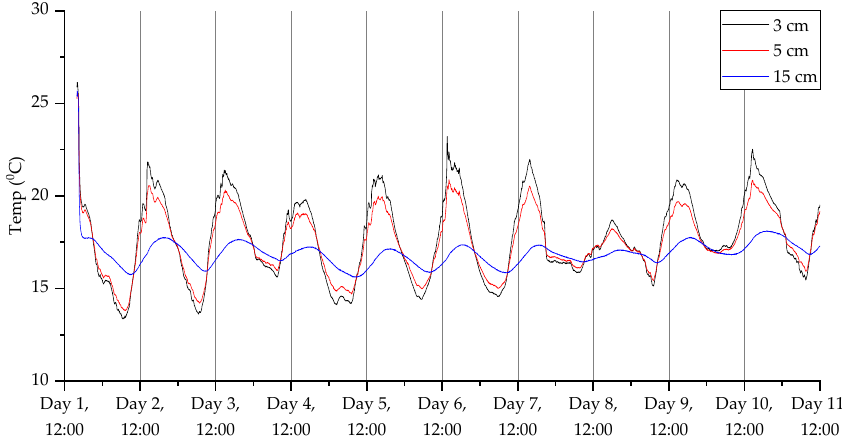
Figure 19. Temperature measurements for the third deployment in Wellesbourne campus woodland. Figure 19: Temperature measurements for the third deployment in Wellesbourne cam ‐ Data collection commenced on 26 August 2022 at 16:00 (24 h pus woodland. Data collection commenced on 26 August 2022 at 16:00 (24 h time).